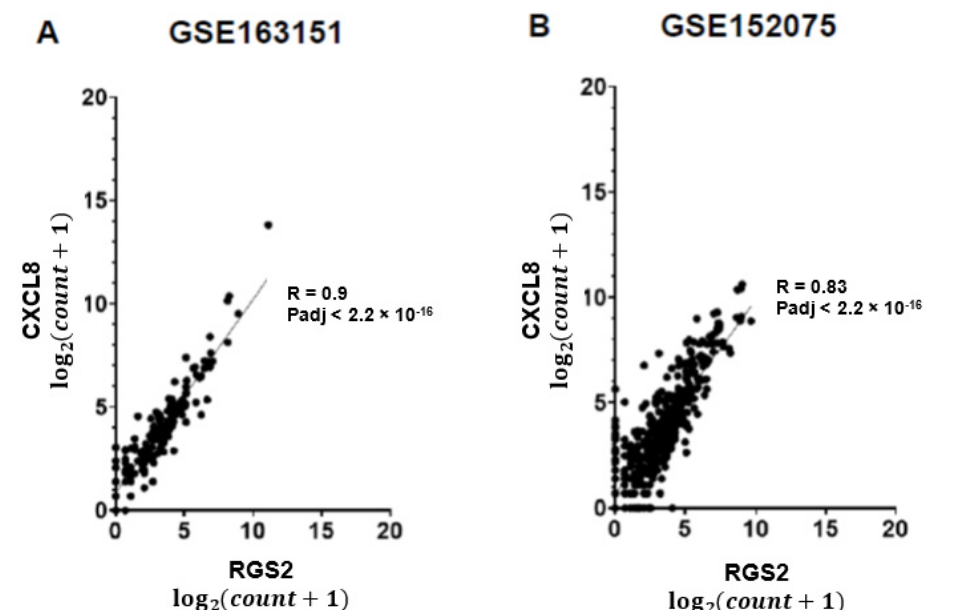
Figure 2. Positive correlation between expression levels of RGS2 and CXCL8 from RNA-sequencing of nasopharyngeal swabs. Spearman correlations are shown for ( A ) dataset GSE163151; ( B ) dataset GSE152075.